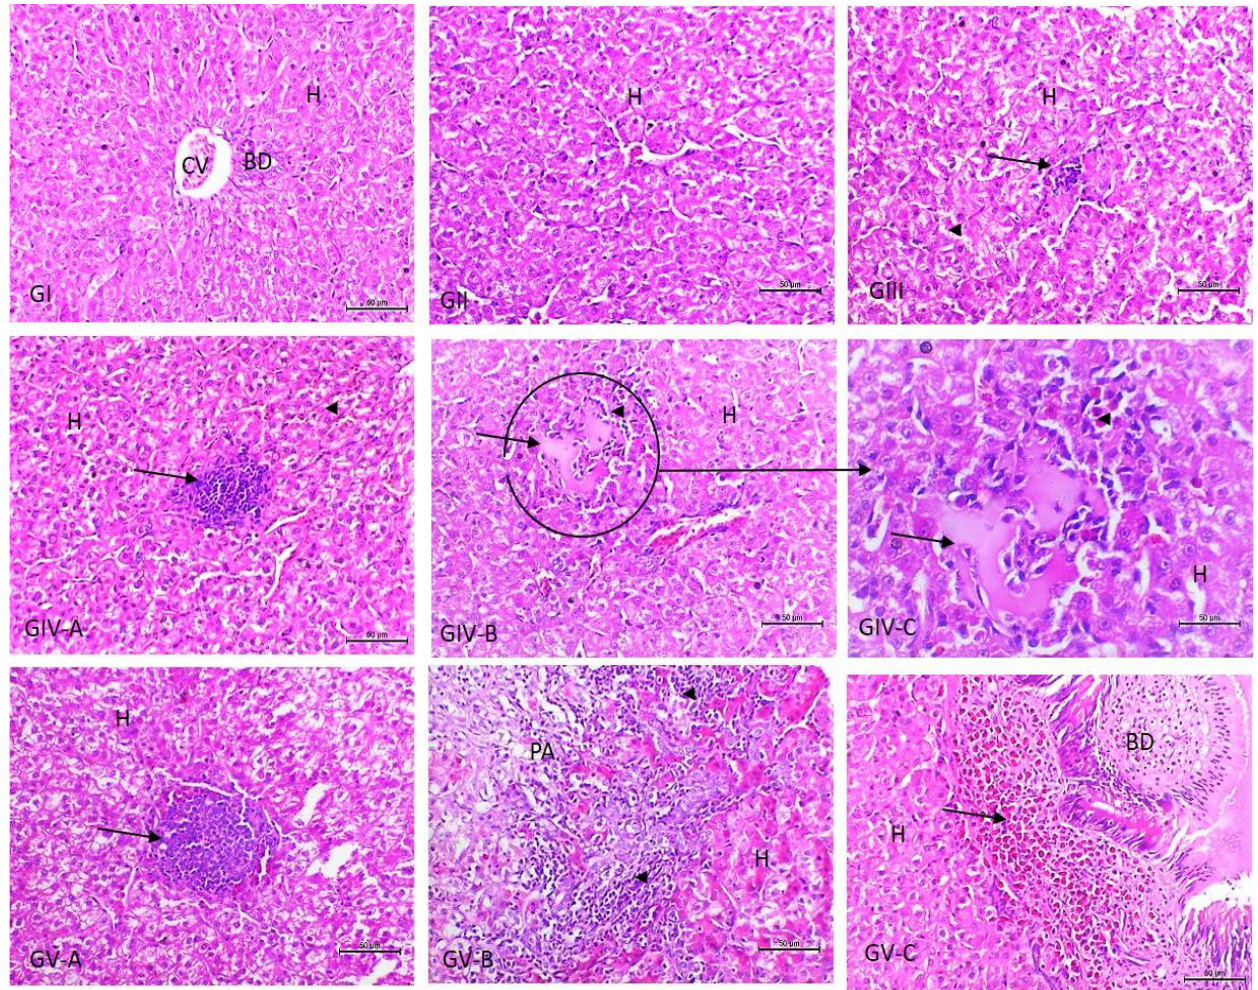
Figure 1. Photomicrograph of liver sections from experimental groups stained with Hx & E stain. G1I and GI1: the liver showing normal architecture, central vein, and intact hepatocytes (H); GIII: there was slight Kupffer cell activation (arrow) and slight vacuolation in the cytoplasm of hepatocyte (arrowhead). GIV-A: moderate Kupffer cell activation (arrow); GIV-B and -C: slight hepatocellular necrosis (arrow) surrounded by a few inflammatory cells (arrowhead); GV-A: a focal collection of a large number of macrophages (granuloma-like) within the hepatic parenchyma (arrow). GV-B: hepatocellular necrosis in the portal area (PA) with infiltration of several chronic inflammatory cells within and around the necrosed areas (arrowhead); GV-C: periductal inflammatory cell infiltration with hyperplasia of the bile duct lining epithelium (arrow) in the PA. The bar size of each picture is included under each picture.